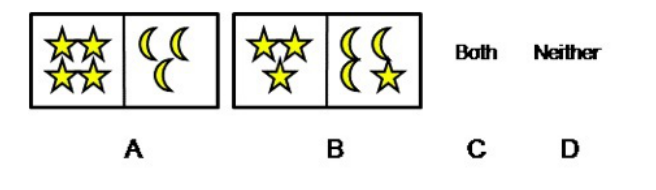
Illustration of figures used in Experiment